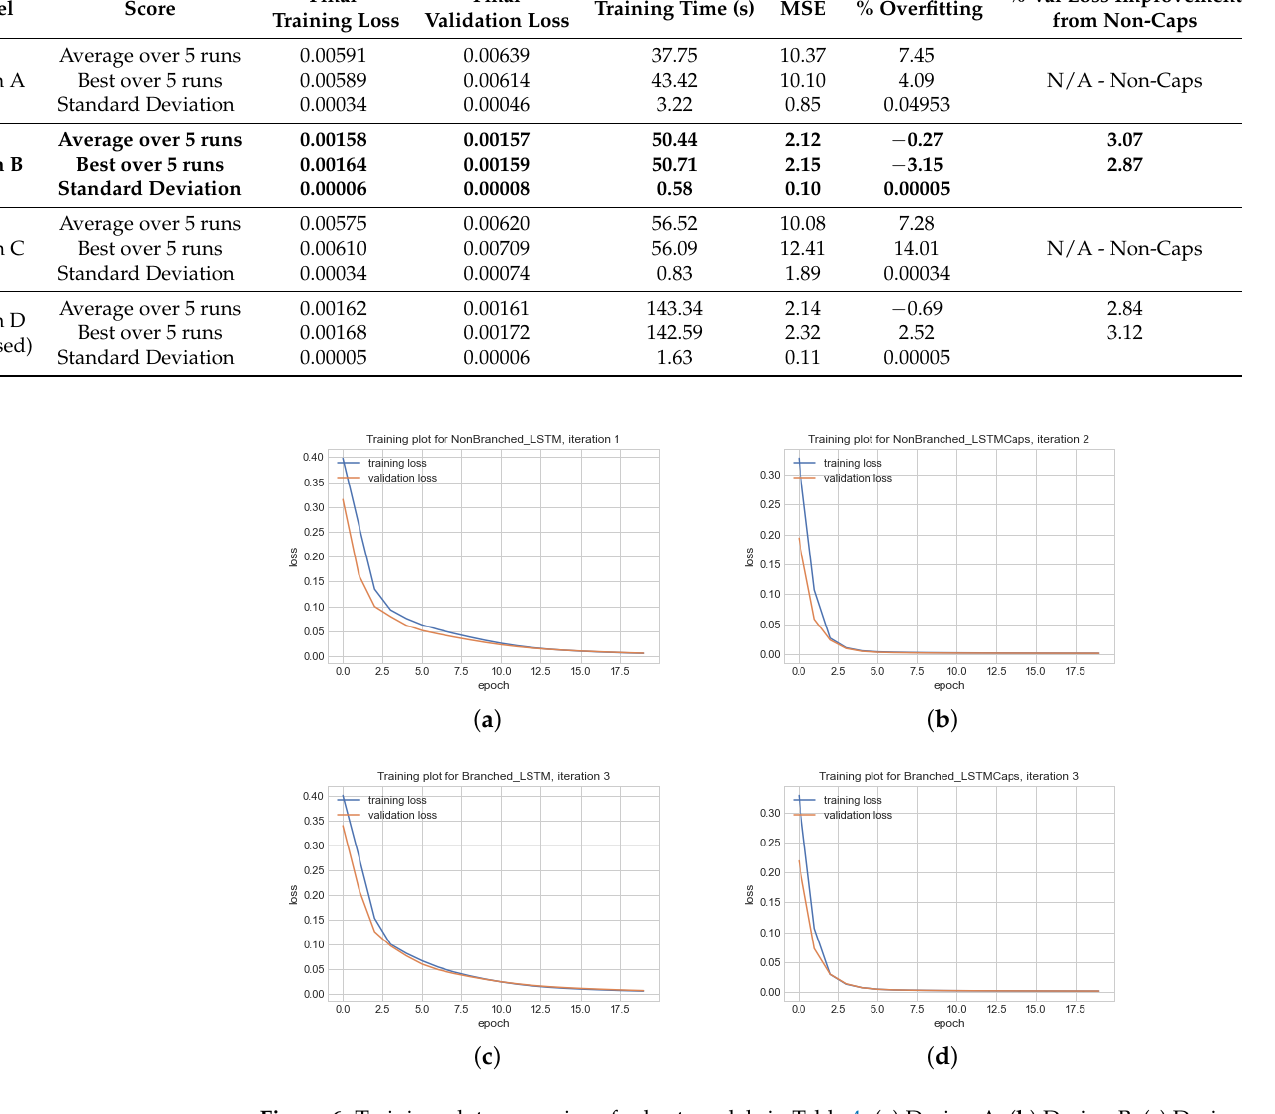
Figure 6. Training plot comparison for best models in Table 4. ( a ) Design A; ( b ) Design B; ( c ) Design C; ( d ) Design D